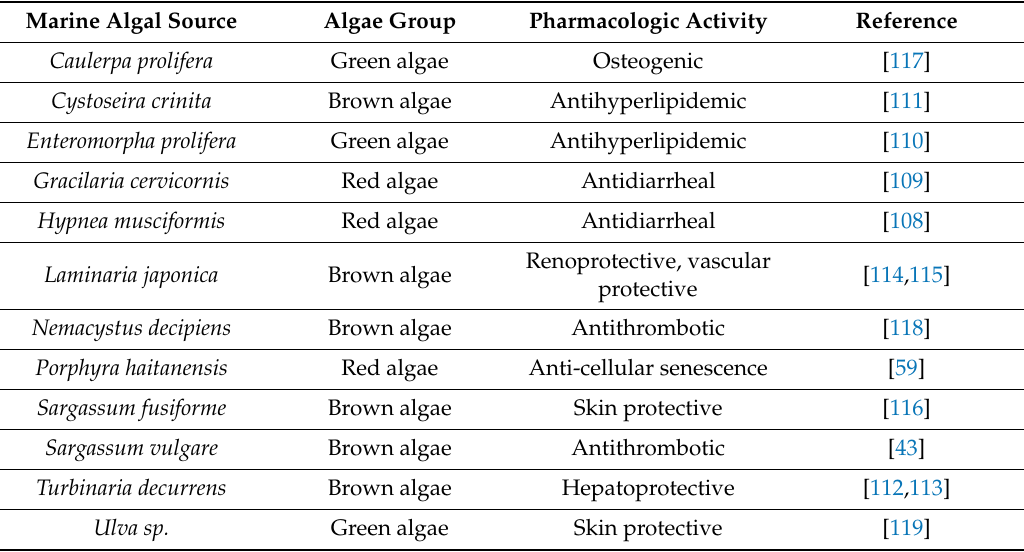
Table 11. Other marine algae source and its di ff erent pharmacologic activity attributed to